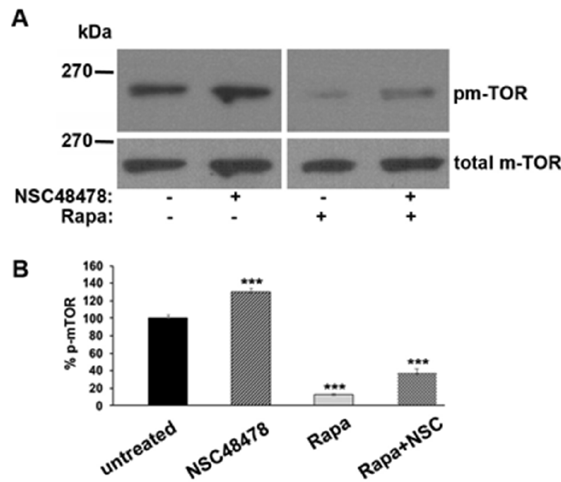
Figure 5. Phosphorylated m-TOR Ser-2448 isoform increases after NSC48478 administration. ( A ) GT1 cells grown on dishes in 1% serum were left untreated (-) or treated (+) as indicated. Rapamycin 100 nM was used as control for the procedure. SDS-PAGE followed by immunoblotting with anti- phospho Ser-2448 antibody revealed an increase in p-m-TOR after NSC48478 administration. Total m-TOR was revealed by probing the same membranes with anti-m-TOR antibody after stripping. ( B ) The gels are representative of three independent experiments plotted in the graph, where NSC48478 and Rapa treatments were compared to untreated conditions (expressed as 100%) (*** p < 0.001). Collectively, the data presented so far suggest that the inhibitor acts in an opposite way to Rapamycin, that is, by blocking m-TOR-dependent autophagy and promoting an m-TOR-independent route (see discussion for